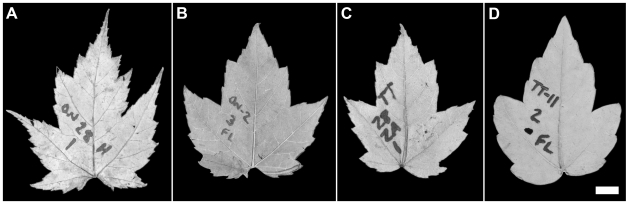
Representative leaves of Acer rubrum used in study.Leaf derived from Ontario seed stock grown in (A) Rhode Island and (B) Florida; leaf derived from Florida seed stock grown in (C) Rhode Island and (D) Florida. For all leaves, petioles have been removed and minor damage along the margin has been corrected with white lines. Bar (for all leaves) = 1 cm.